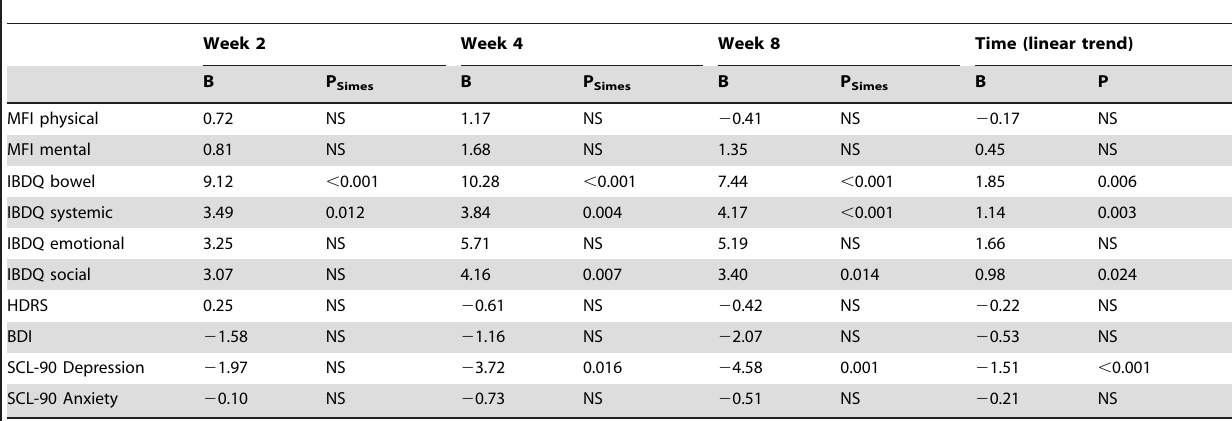
Table 4. Effects of anti-TNF- a on fatigue, quality of life and mood compared to baseline scores, corrected for disease activity.